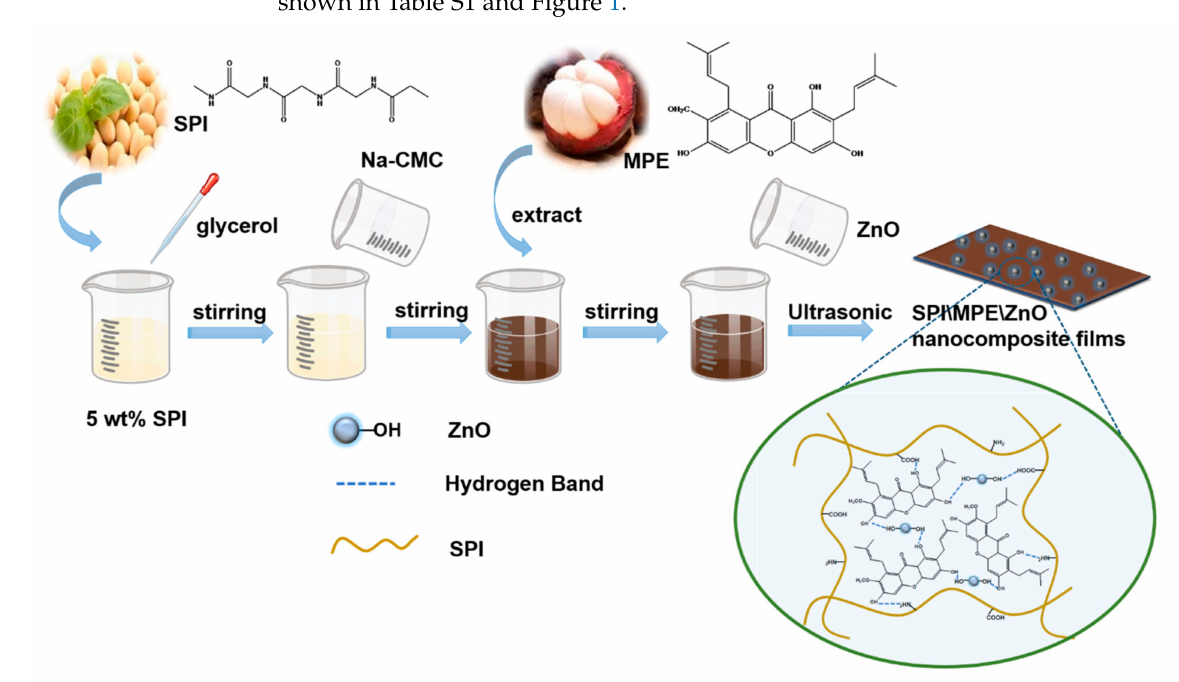
Figure 1. Schematic of the preparation of nanocomposite